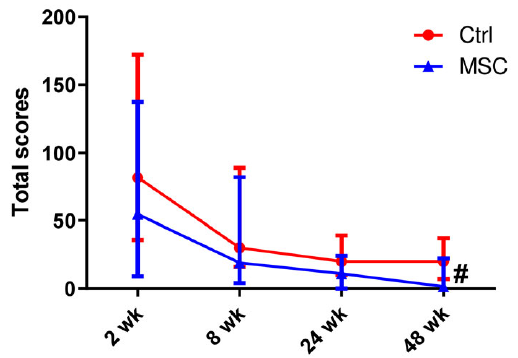
Figure 1. Dynamic changes in lung CT scores in patients with COVID-19. Data are presented as a median and IQR. Mann–Whitney U test for comparing the control and MSC groups at each time-point: #, p ≤ 0.05. The red line represents the Control group; the blue line represents the MSC group. 2.4. The Dynamic Profile of Hematological Parameters in Patients with COVID-19 Blood parameter comparisons in patients with COVID-19, depending on the time of assessment, are presented in Figure 2. The differences in the white blood cells (WBC), gran- ulocytes (Gra), and lymphocytes (Lym) counts as well as the neutrophil (Neu), eosinophils (Eo), and monocytes (Mo) percentages did not reach significance between the two groups, but the dynamic profile showed some fine changes. Thus, the count of WBC increased on day 7 with a subsequent decrease on day 28 in both the MSC and Control groups. In the MSC group, the count of granulocytes (Gra) decreased on day 28 compared to day 0 significantly, in contrast to the Control group. Neutrophil (Neu) percentages gradually decreased during the first 28 days in both groups, but the percentage of banded neutrophils on day 14 was significantly lower in the MSC group. A slight but significant increase in the percentage of eosinophils (Eo) on day 28 was observed in the MSC group compared to the beginning of observation. The percentage of Eo increased two-fold from days 14 to 28 in the Control group. The percentage of monocytes (Mo) did not change during the first four weeks in the Control group, whereas in the MSC group, it increased significantly from day 14. Compared to the beginning of hospitalization, the percentage of lymphocytes (Lym) increased in both groups and reached a significant difference between groups on day 28. Furthermore, the lymphocyte count doubled on day 7 in the MSC group and day 14 in the Control group, respectively. Compared to the initial day, ESR decreased in both the MSC and Control groups on days 7 and 28, respectively (Figures 2A and